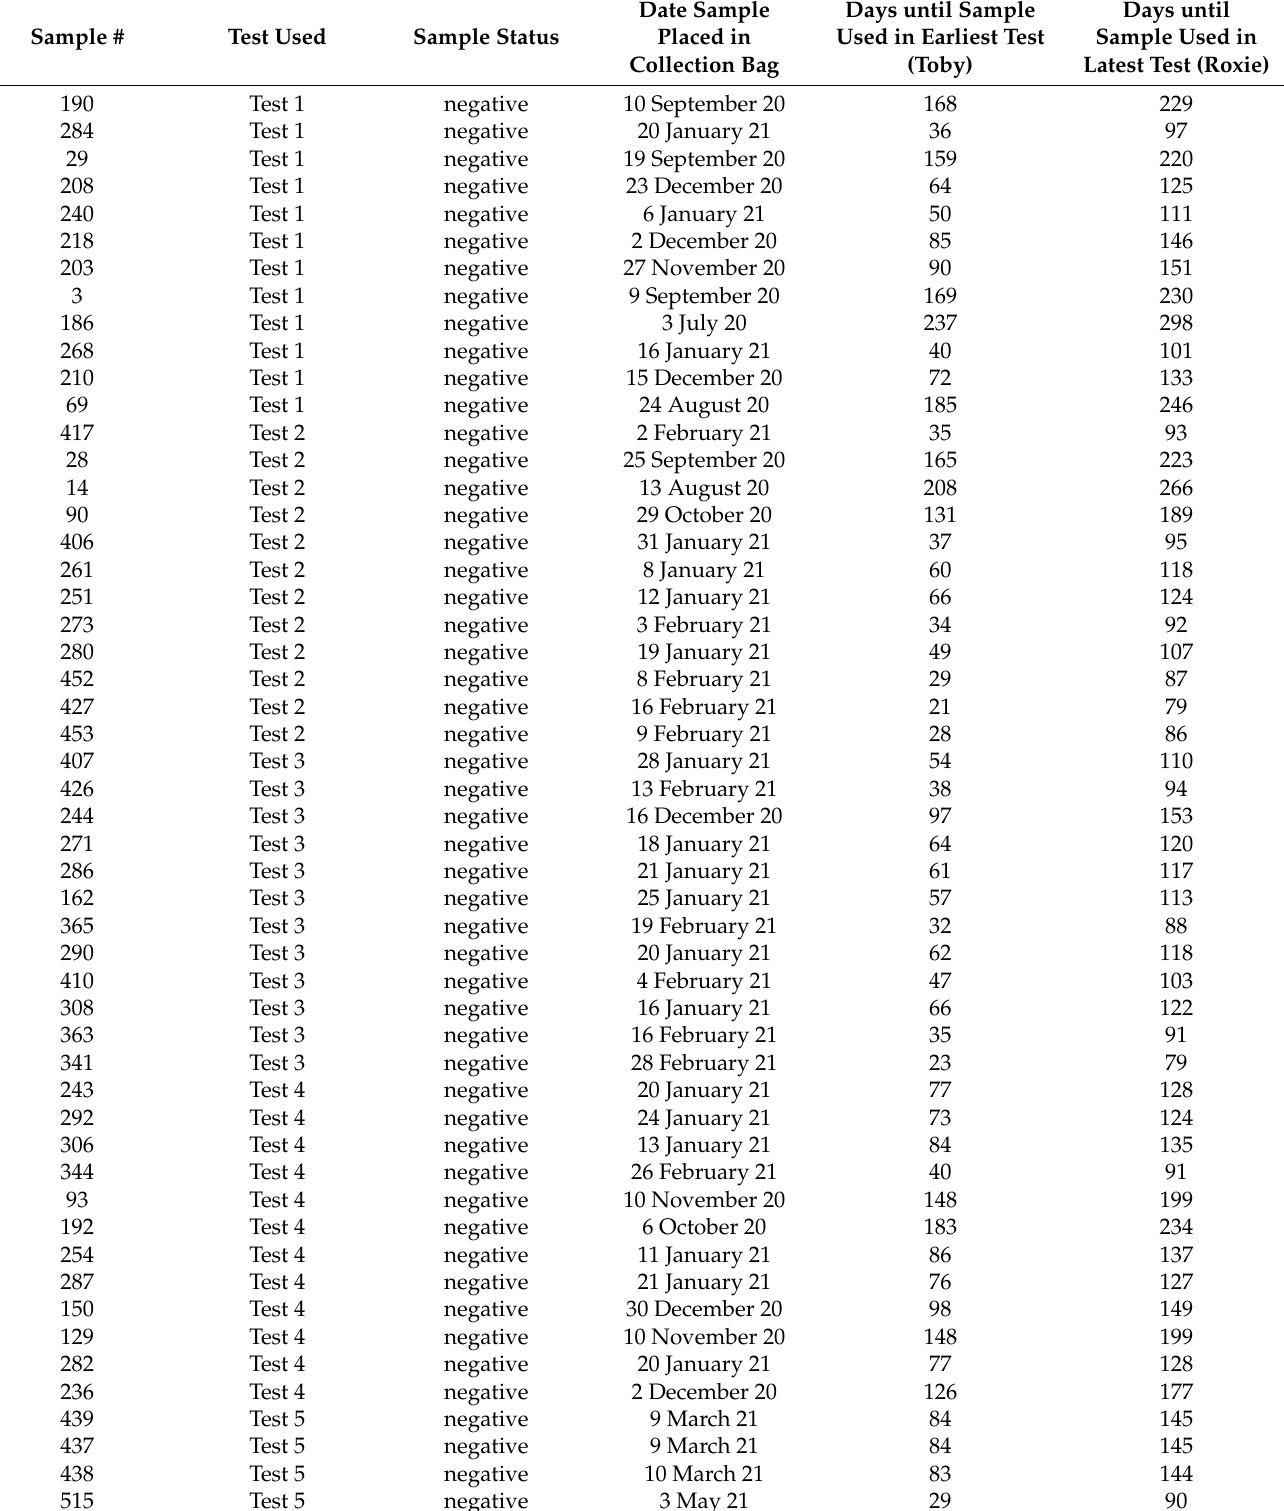
Table A3. Table of canine test